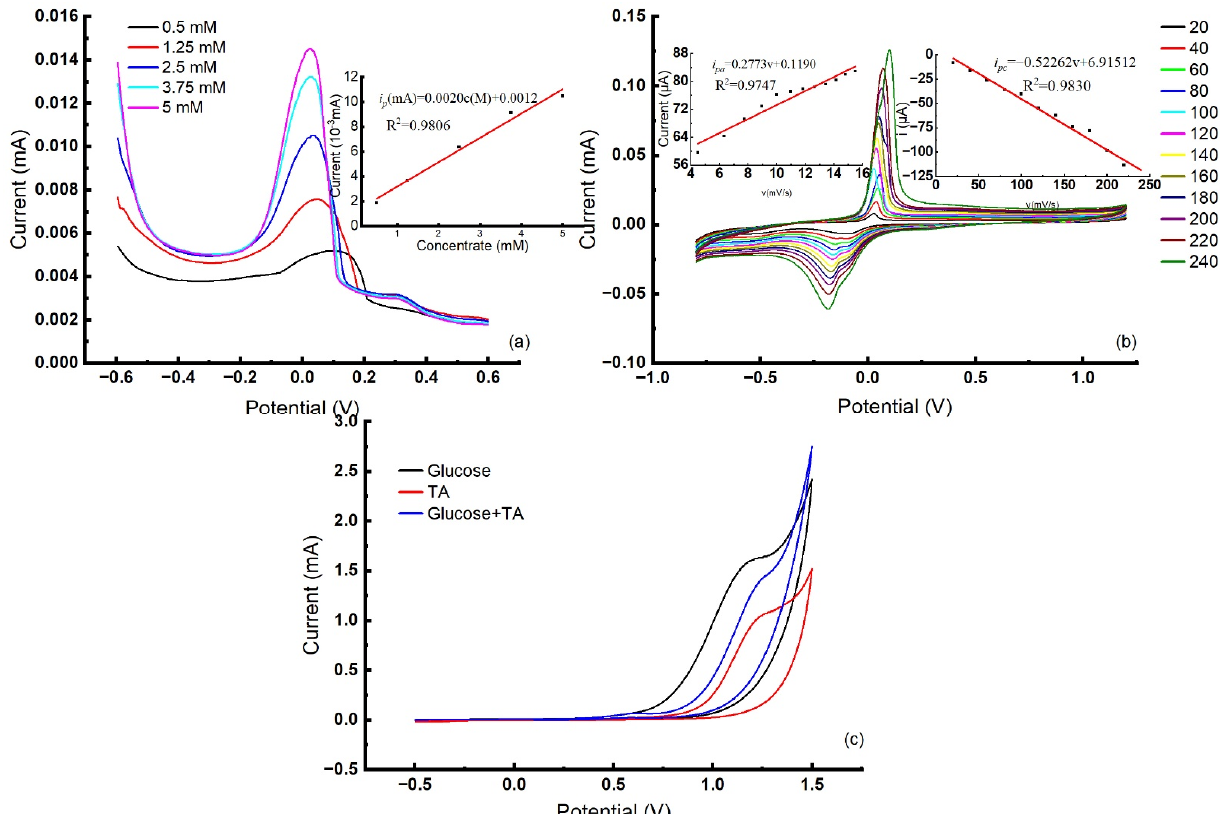
Figure 5. Electrochemical behavior of TA at Cu/PTRP/Nafion/GCE: ( a ) DPV curves of detecting 0.5 M~5 M TA solution with Cu/PTRP/Nafion/GCE; ( b ) CV curves of detecting 0.5 M~5 M TA solution with Cu/PTRP/Nafion/GCE; ( c ) CV curves of detecting Glu solution, TA solution and mix solution of Glu and TA with Cu/PNR/GCE.